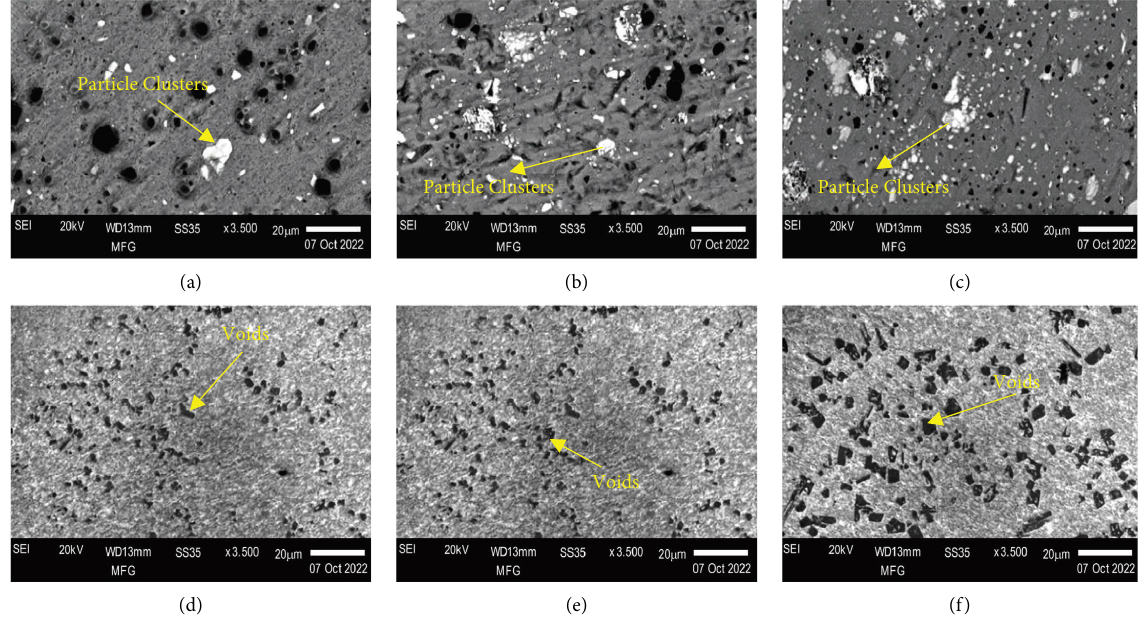
Figure 5: Microstructure images of AA5052-B 4 Cp MMCs: (a) 8% AA5052/95-B 4 C/145; (b) 8% AA5052/95-B 4 C/95; (c) 8% AA5052/95- B 4 C/95; (d) 18% AA5052/95-B 4 C/145; (e) 18% AA5052/95-B 4 C-95; (f) 18% AA5052/145-B 4